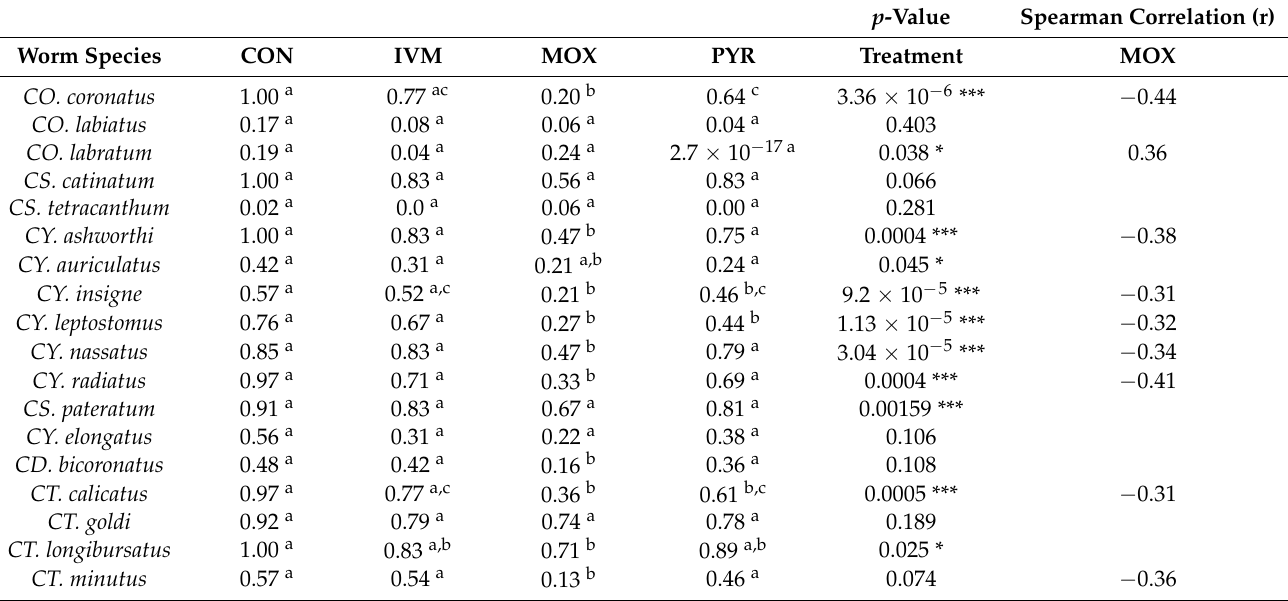
Table 4. ANOVA and Spearman correlations based on frequency of